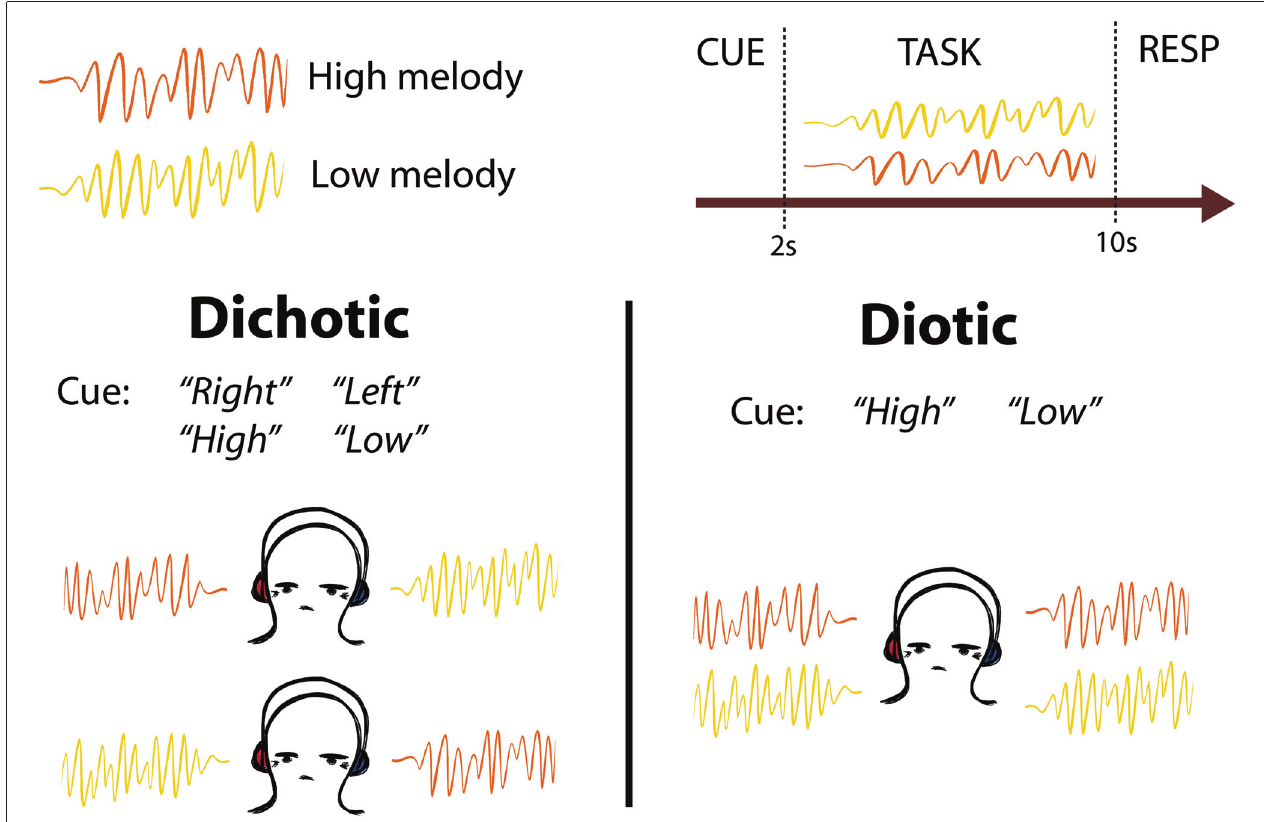
FIGURE 1 | Schematic of task design. Two competing melodies were presented simultaneously using either dichotic (one melody played to each ear) or diotic (both melodies played to both ears equally) listening. Subjects were cued to listen to the melody on the left or right ear (“Left” or “Right”), or to listen to the melody that was higher or lower in pitch (“High” or “Low”). After the melodies were completed, subjects were cued to Respond (RESP) with button presses to indicate whether they heard a pitch change in the cued